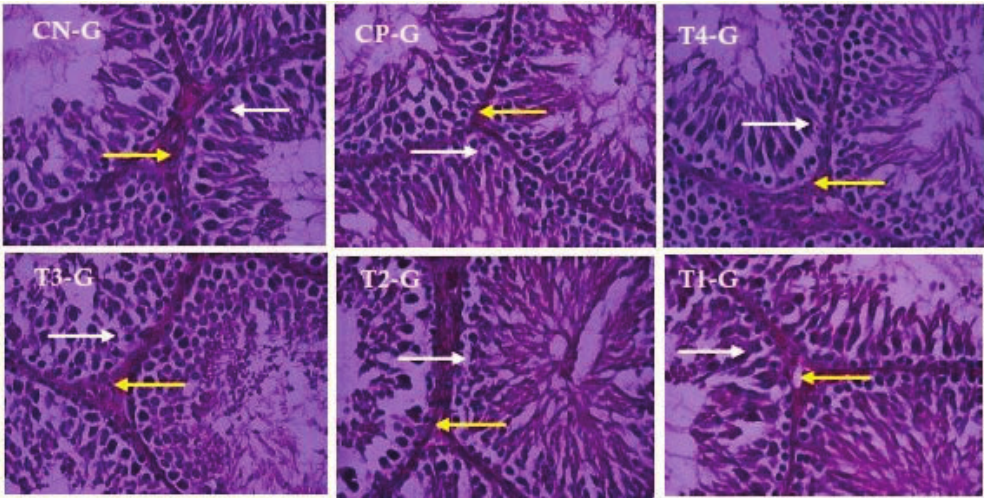
Figure 2. histological preparation of testis was stained with hematoxilin eosin in each group. : Sertoli and Leydig